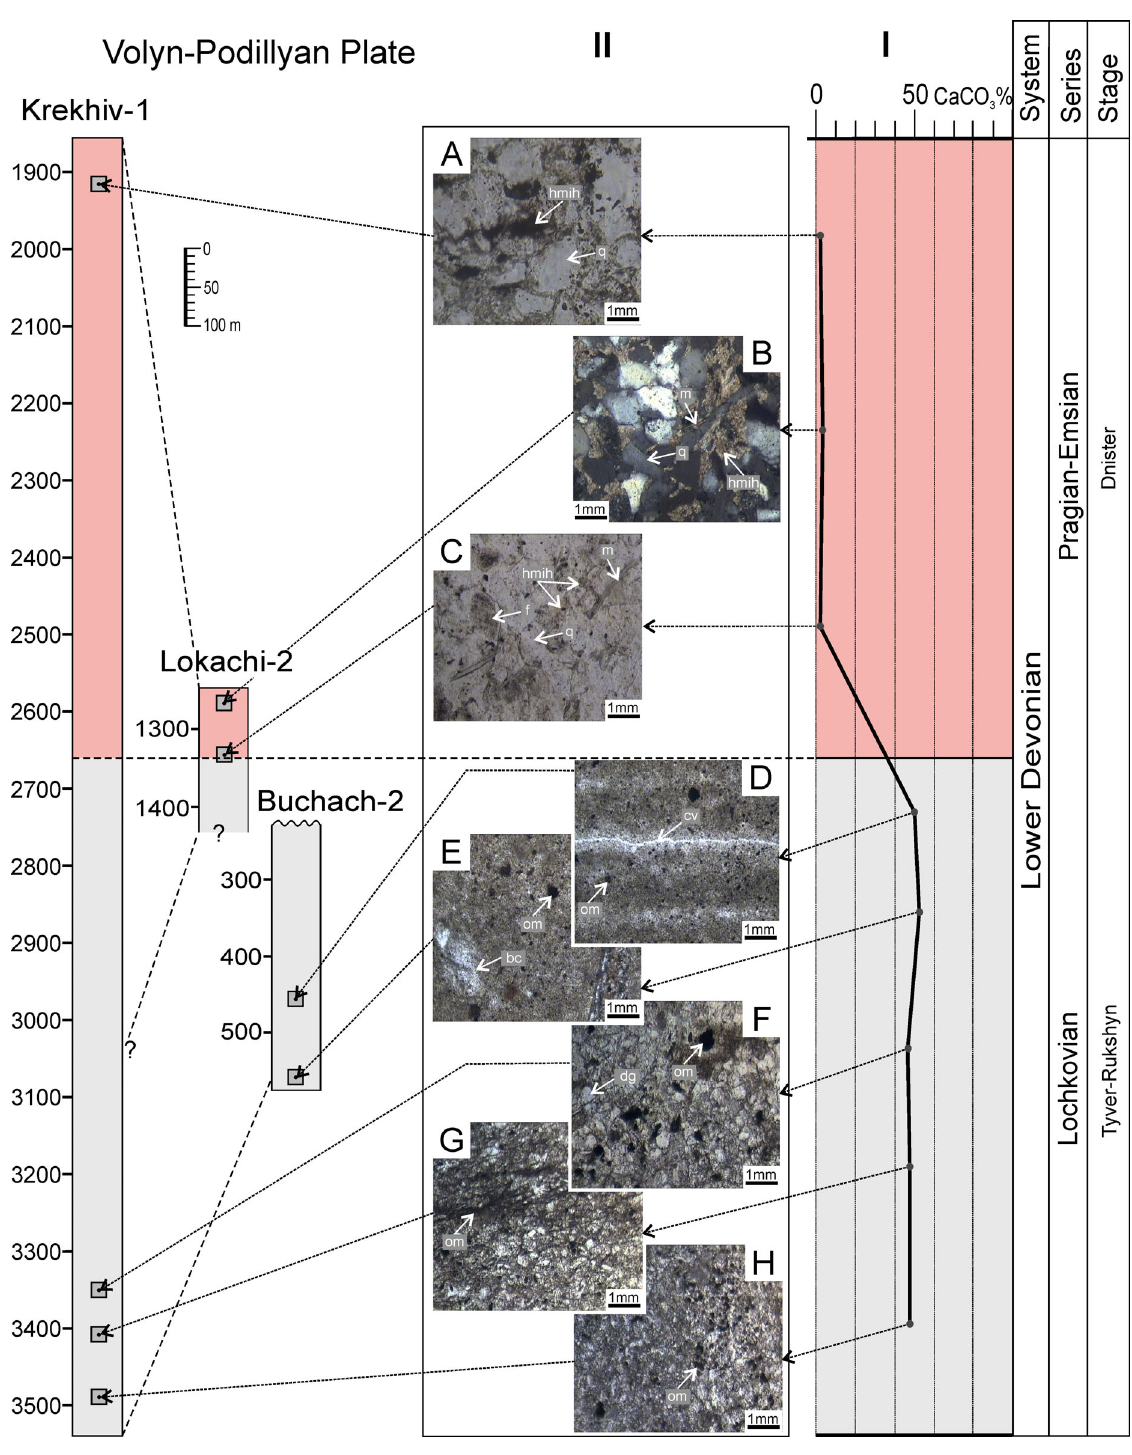
Fig. 3. ( I ) CaCO 3 content in the Lower Devonian sequence of the boreholes (Volyn-Podillyan Plate). ( II ) Photomicrographs of the Lower Devonian rocks from the Krekhiv-1, Lokachi-2 and Buchach-2 boreholes (Volyn-Podillyan Plate). Photomicrograph B was made without analyser, all the rest – with analyser. A, B, C, sandstones with hydromica matrix saturated with iron hydroxide (hmih), quartz (q), feldspar (f) and muscovite (m): A – depth interval 1916.2–1918.6 m, B – depth interval 1267.5–1268 m, C – depth interval 1337–1337.8 m; D, E, G, H, marlstones with pyritized streaks of organic matter (om): D – calcite veinlet (cv), depth interval 453–459 m, E – problematic bioclasts (bc), depth interval 555–560 m, G – depth interval 3405.1–3414.7 m, H – depth interval 3486.6–3497.6 m; F – dolomitized limestones with dolomite grains (dg) and organic matter (om), depth interval 3348.7–3356.6